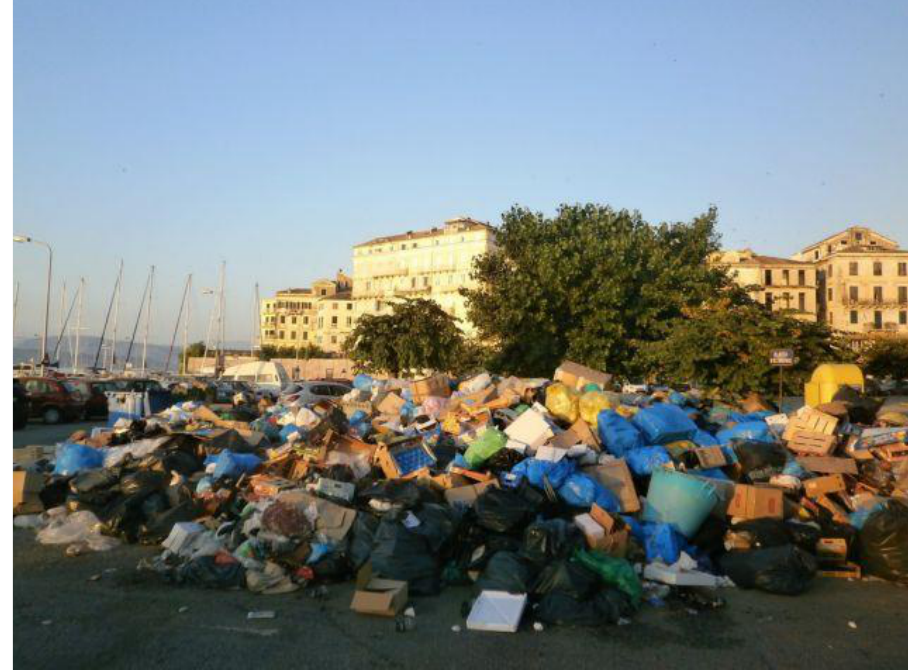
Figure 1. The waste situation in Corfu during the summer of 2018.